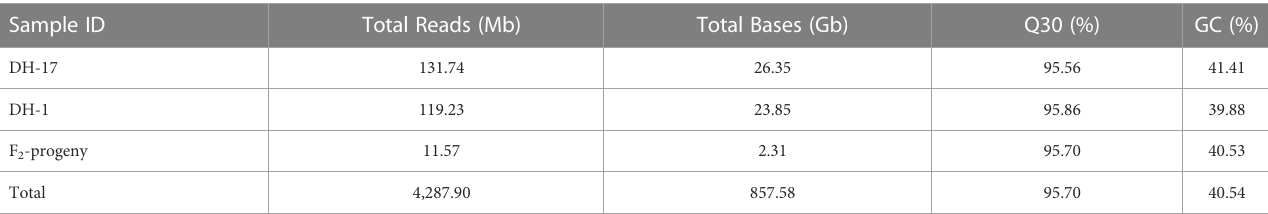
TABLE 1 Summary of the SLAF-sequencing